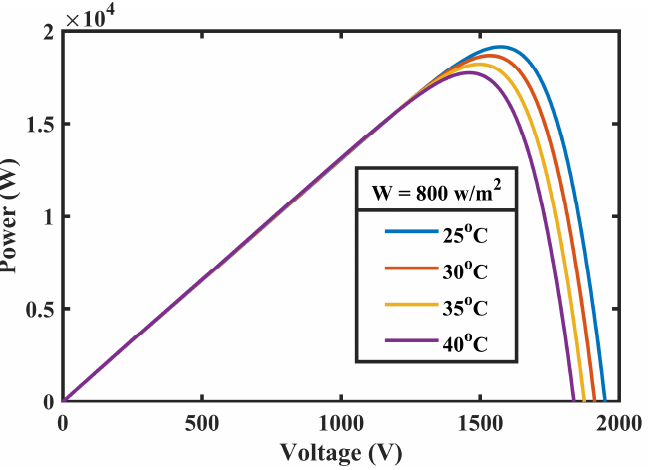
Figure 3. PV curve at different temperatures.